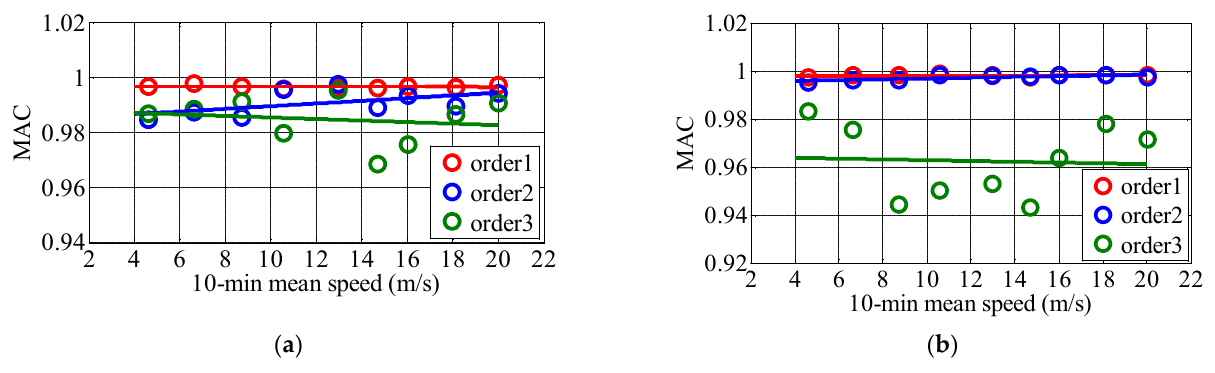
Figure 17. The first three mode shapes along x -and y -axes under different wind speeds. ( a ) along x - axis; ( b ) along y -axis.